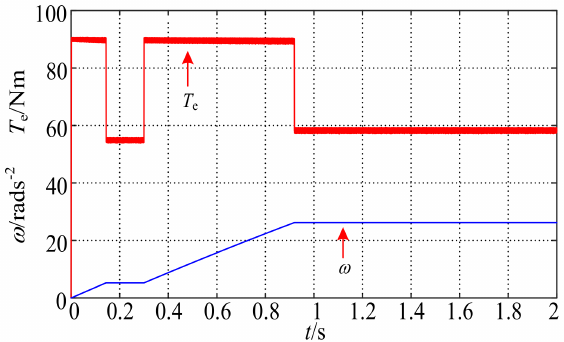
Figure 2. Simulation waveform when B m = 0.1645, C m =